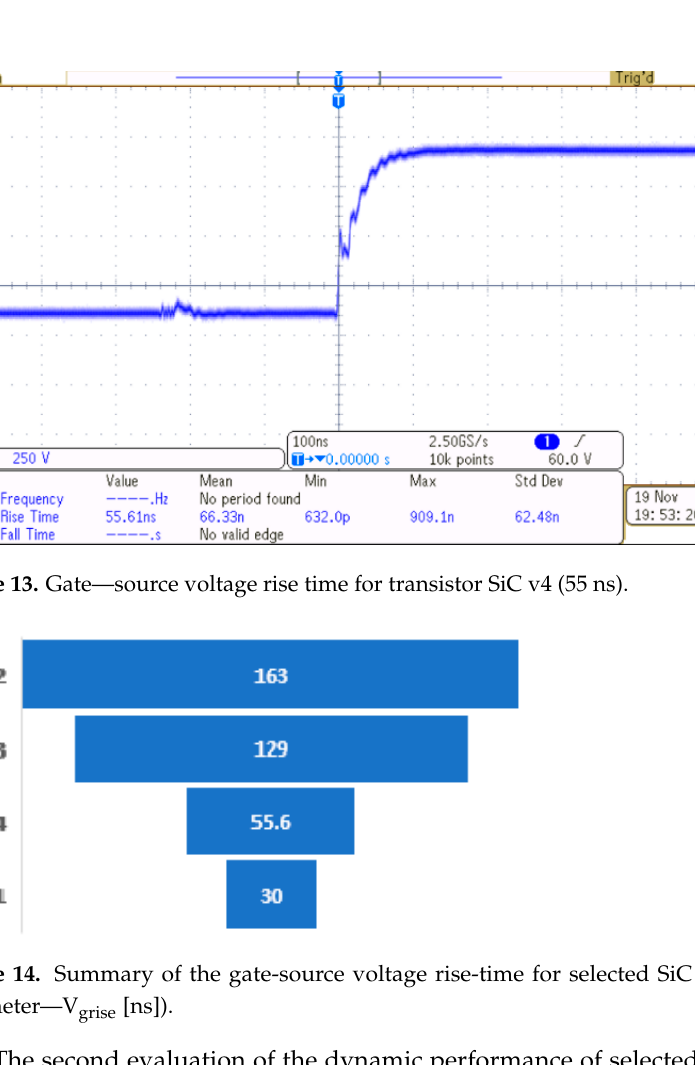
Figure 14. Summary of the gate-source voltage rise-time for selected SiC transistors (evaluated pa- rameter—V grise [ns]).